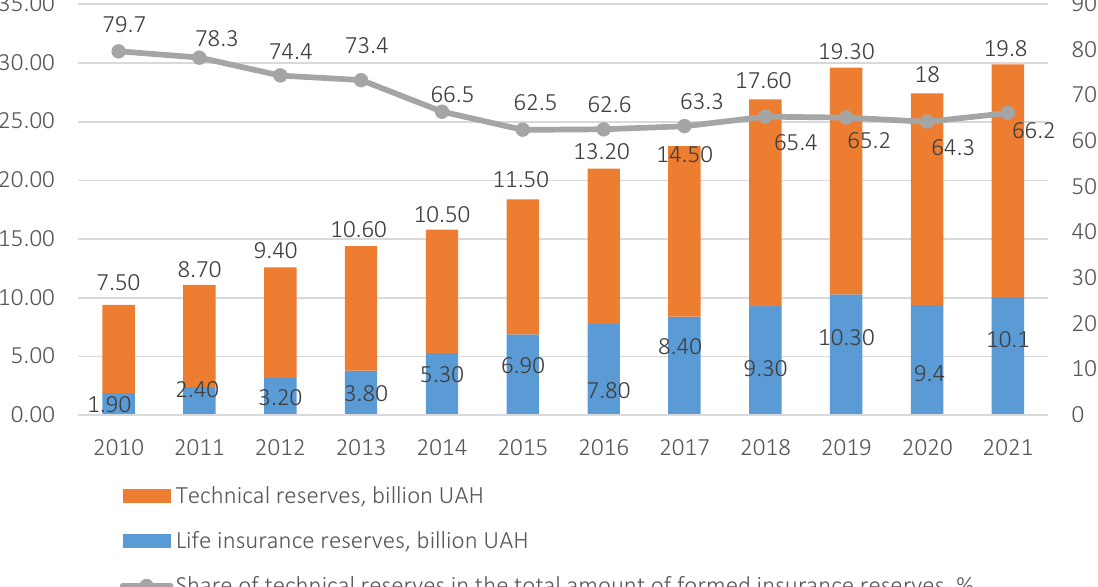
Figure 8. Volumes of formed insurance reserves by type in